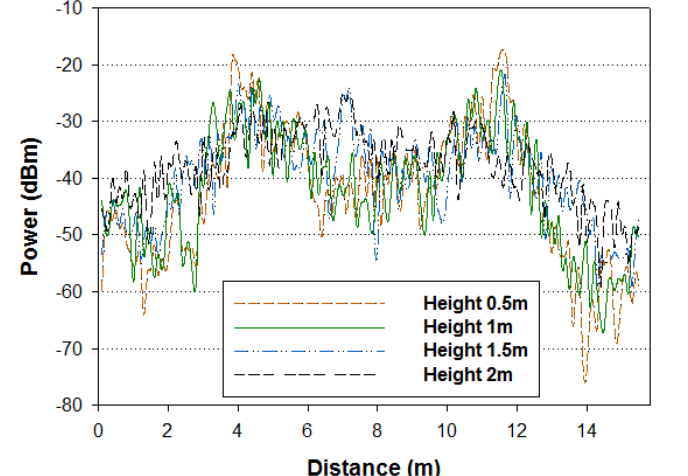
Figure 10. Estimation of radials of received power (dBm) along the X-axis for Y = 1.25 m along the indoor passenger wagon